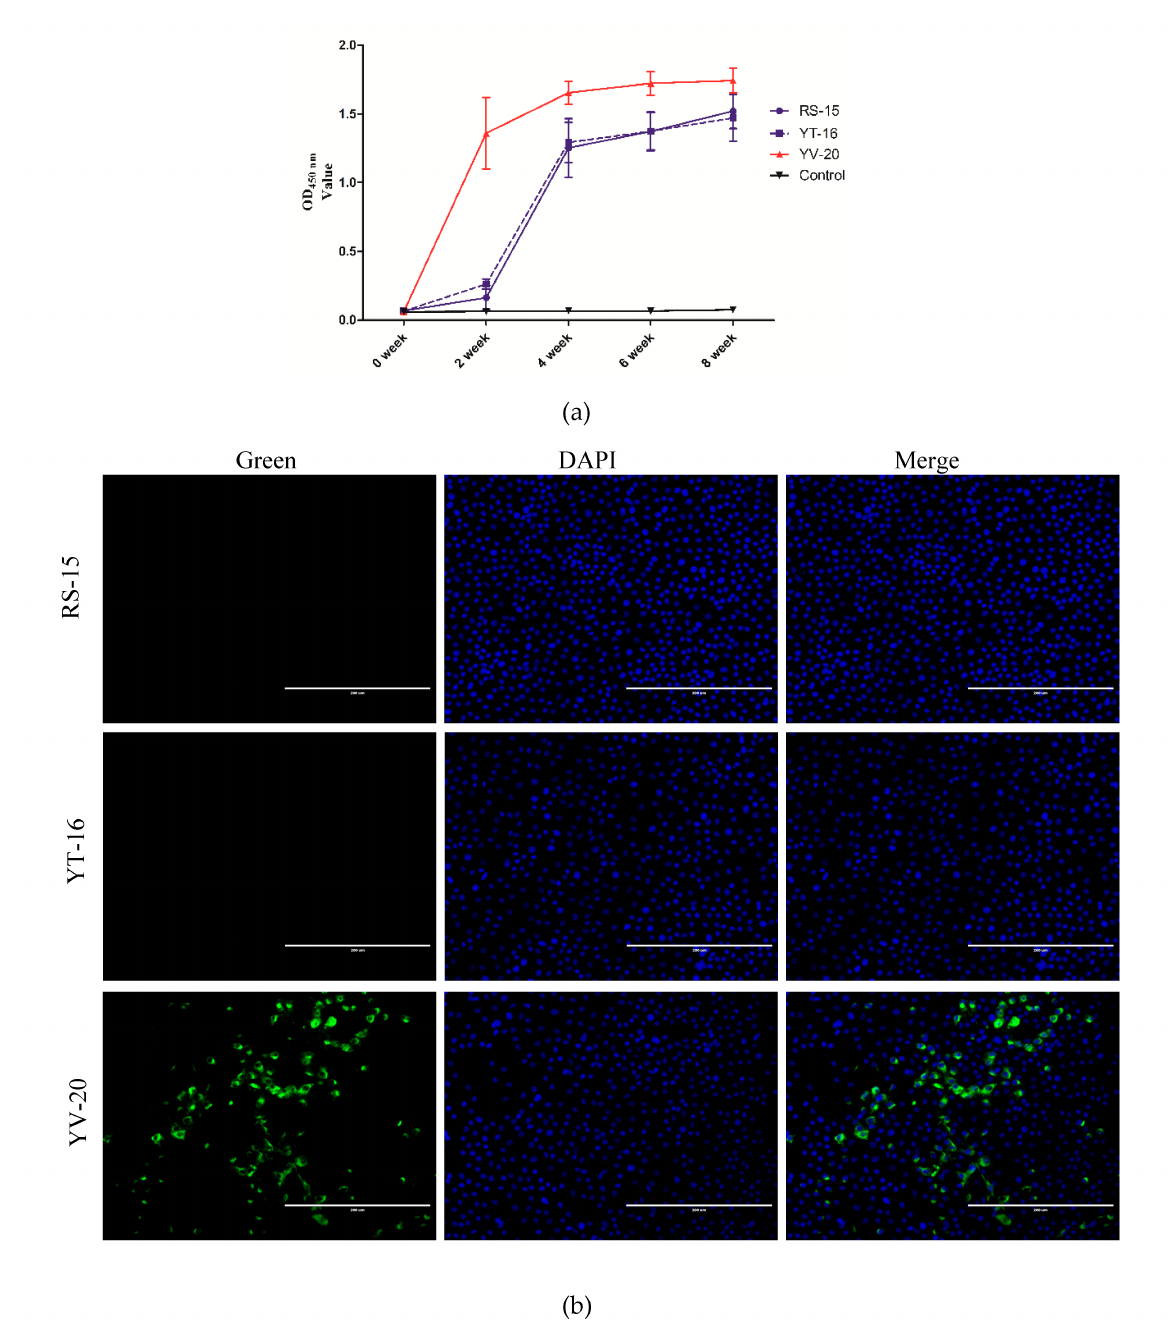
Figure 7. Antibody responses to the identified epitopes. ( a ) Humoral responses elicited by the aa 243-249 and aa 243–262 epitopes; ( b ) Reaction of antibodies elicited by epitopes with the TGEV virus in PK-15